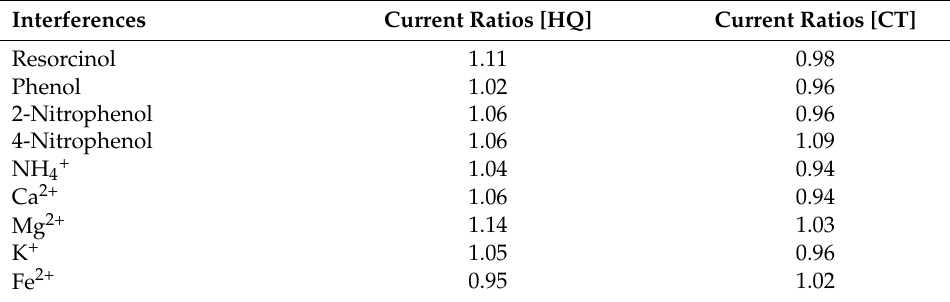
Table 1. Possible interferences tested with the proposed